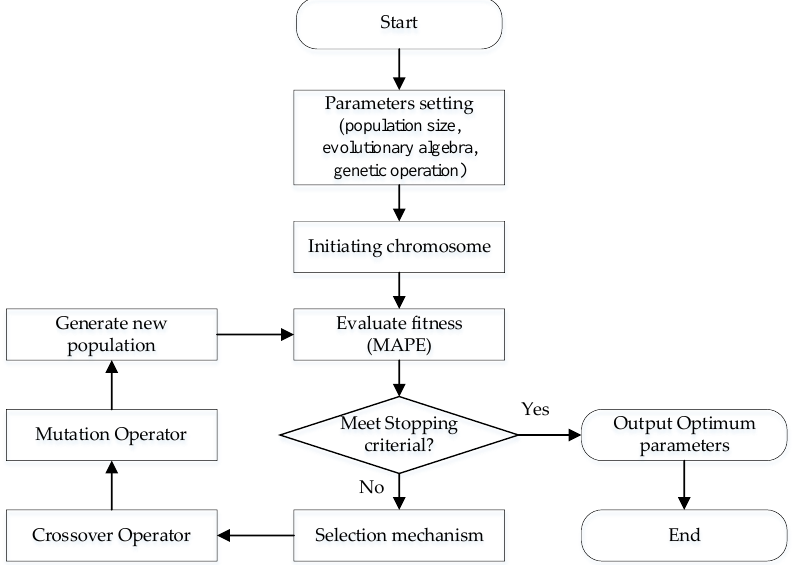
Figure 4. Diagram of the optimization procedure of GA.